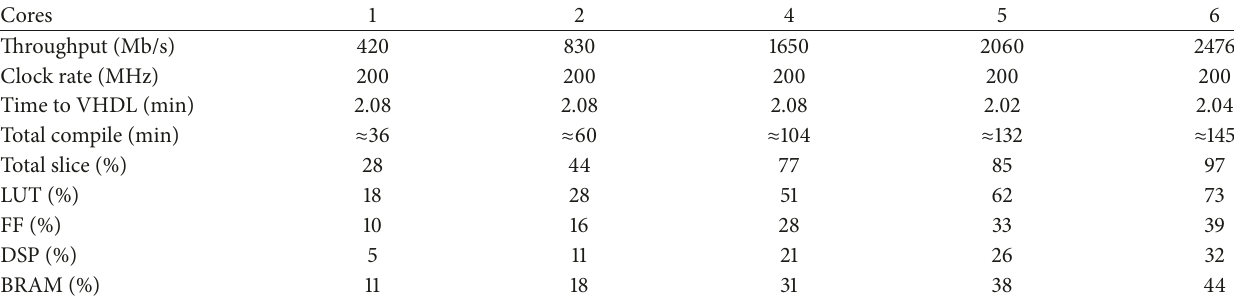
Table 8: Performance and resource utilization comparison, after mapping onto the FPGA, for versions with varying number of cores of the QC-LDPC decoder implemented on the NI USRP-2953R containing the Xilinx Kintex-7 (410t) FPGA.